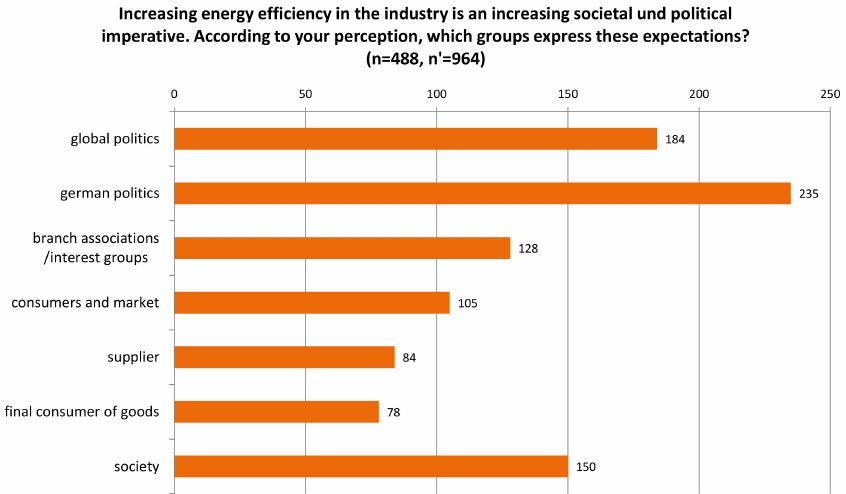
Figure 8. The attribution of the external imperative for energy e ffi